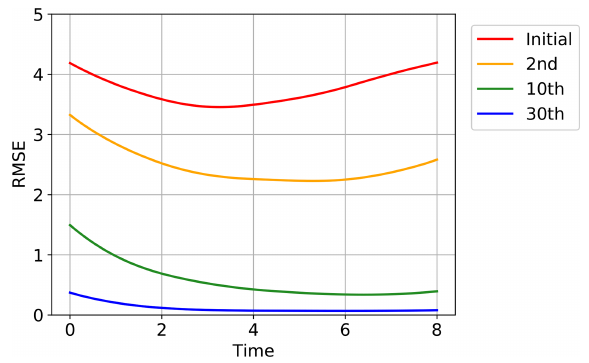
Figure 11. The root mean square errors over all the 400 variables at each time step for the initial guess (red line), the second iteration (yellow line), the 10th iteration (green line), and the 30th iteration (blue line) in the same trial as Fig.